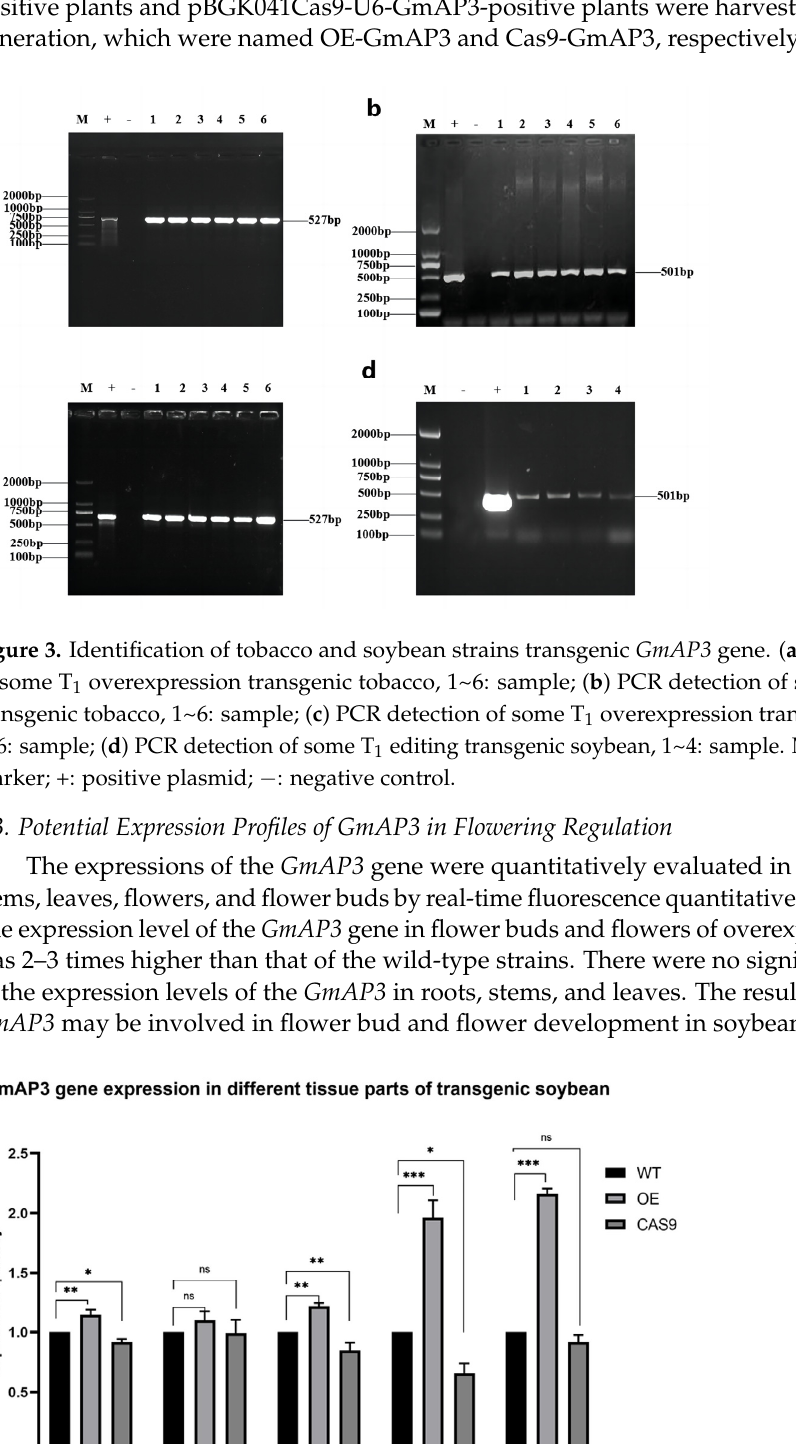
Figure 5. Mutation type and mutation efficiency analysis of gene-edited strains. ( a ) Partial sequence of mutation sites in transgenic soybeans; ( b ) peak map of target mutation in some plants; ( c ) predic- tion diagram of tertiary structure of some proteins. 2.4. GmAP3 Regulated the Expression of Genes Involved in Flower Development To analyze the potential functions of the GmAP3 in flower buds and flower develop- ment, we validated the expression of known genes critical for plant flower development by qRT-PCR. Total RNA was extracted from leaves of OE-GmAP3, Cas9-GmAP3, and control plants. We downloaded five known genes necessary for plant flower development from the NCBI database. FUL ( FRUITFUL ), AP1 ( APETALA 1 ), and LFY ( LEAFY ) are re- lated to floral organ development. SOC1 ( SUPPRESSOR OF OVEREXPRESSION OF CO 1 ) is involved in regulating flowering time. SEP ( SEPALLATA ) is involved in many pro- cesses such as flower development and seed development. The expression levels of FUL, SOC1, and SEP genes were significantly higher in OE-GmAP3 plants than in the control, while the expression levels of AP1 and LFY genes were lower than in the control. In Cas9- GmAP3 plants, the expression of FUL and SOC1 genes decreased, the expression of AP1 and LFY genes was higher than that of the management, and the manifestation of the SEP gene did not change significantly (Figure 6). These results indicated that GmAP3 could directly or indirectly participate in flower and seed development pathways in soybean by modulating the expression of genes that are known to be critical for flower development.